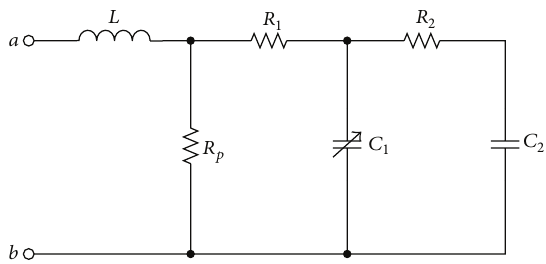
Figure 2: Equivalent circuit developed by Gualous et al. of activated carbon particles and their surface area that varies with the type of activated carbon used and the way it is treated. But the model has six parameters to be identified and does not accurately describe ultracapacitor behavior at low frequencies.